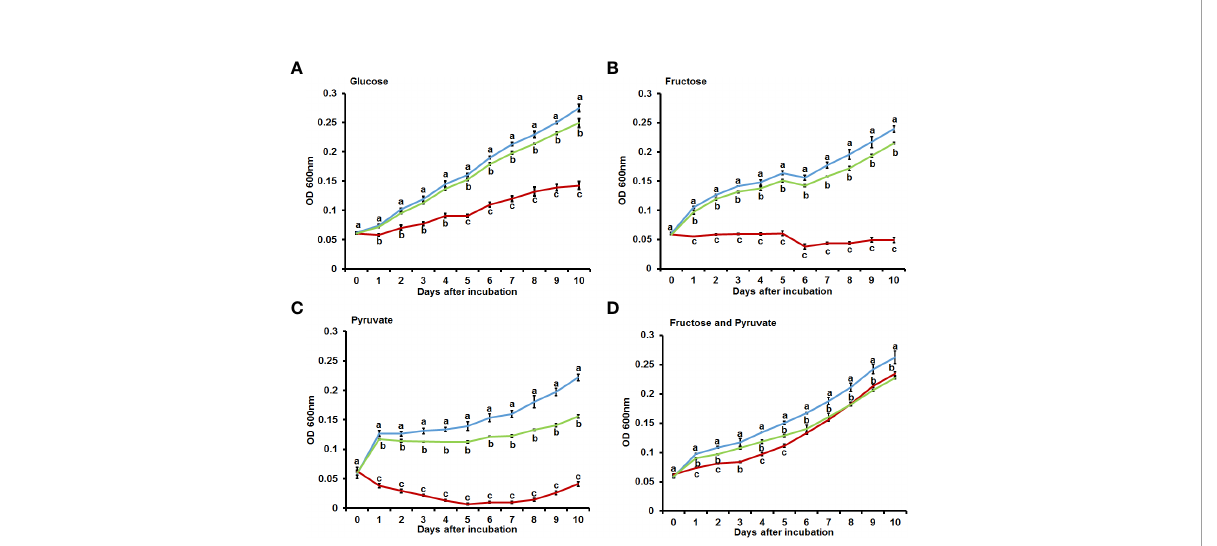
FIGURE 2 Growth assay in M9 minimal media with diverse carbon sources. Bacterial growth in M9 minimal media with (A) glucose (0.4%), (B) fructose (0.4%), (C) pyruvate (0.4%), and (D) fructose (0.2%) and pyruvate (0.2%) as carbon sources. The values at OD 600nm were measured for 10 days at 24 h intervals. The error bars from three biological replicates indicate the standard deviation and the different characters above the error bars indicate signi fi cant differences according to ANOVA (p<0.05) with Tukey ’ s HSD test. At least four independent experiments were performed and all experiments displayed similar